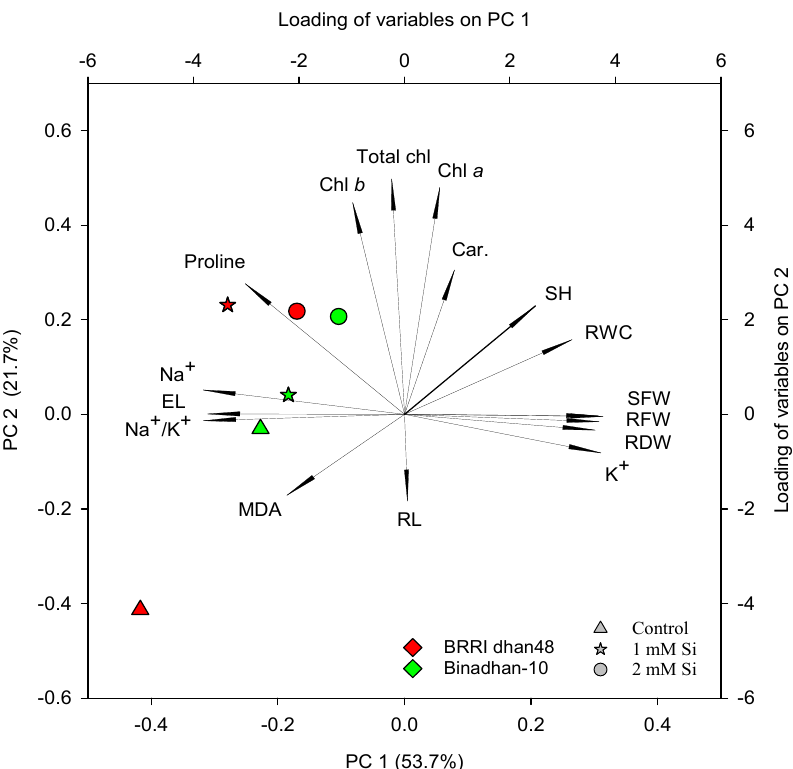
Figure 6. Bi-plot of principal component analysis (PCA) showing the first two principal components (PC 1 and PC 2). For PCA, data on growth and physiological attributes of both BRRI dhan48 and Binadhan-10 rice seedlings under salt stress. Different shapes in the bottom right denote three Si treatments, and red and green colors, respectively, indicating two rice cultivars like BRRI dhan48 and Binadhan-10. SH, shoot height; RL, root length; SFW, shoot fresh weight; RFW, root fresh weight; SDW, shoot dry weight; RDW, root dry weight; Chl a , chlorophyll a ; Chl b , chlorophyll b ; Total chl, total chlorophyll; Car., total carotenoids; RWC, relative water content; EL, electrolyte leakage and MDA, malondialdehyde.